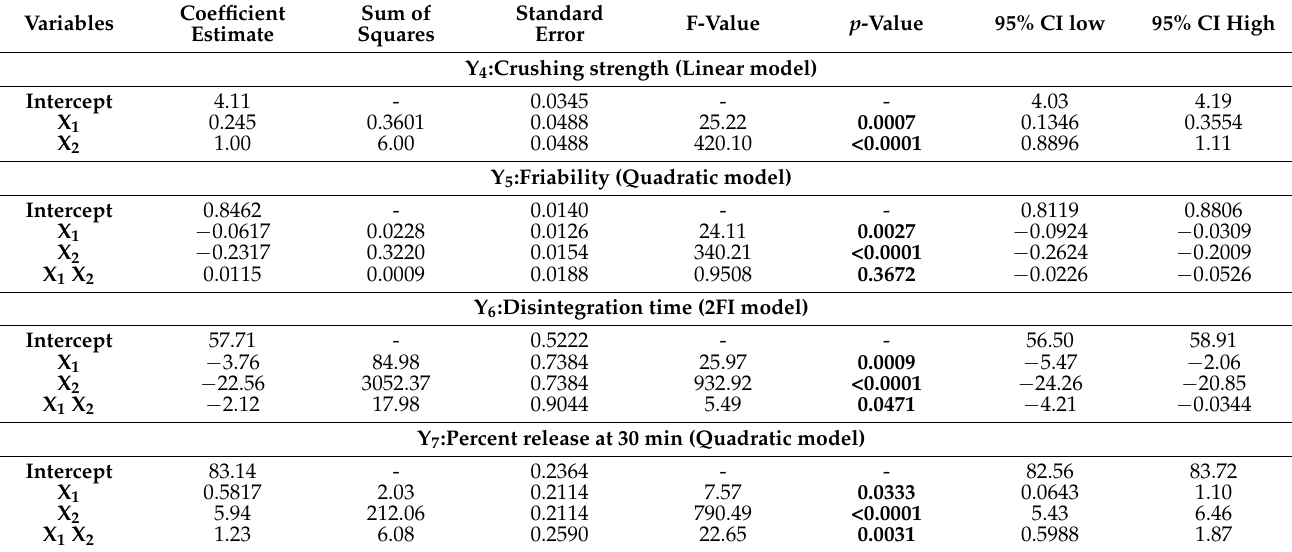
Table 8. ANOVA analysis of ODMTs measured responses.